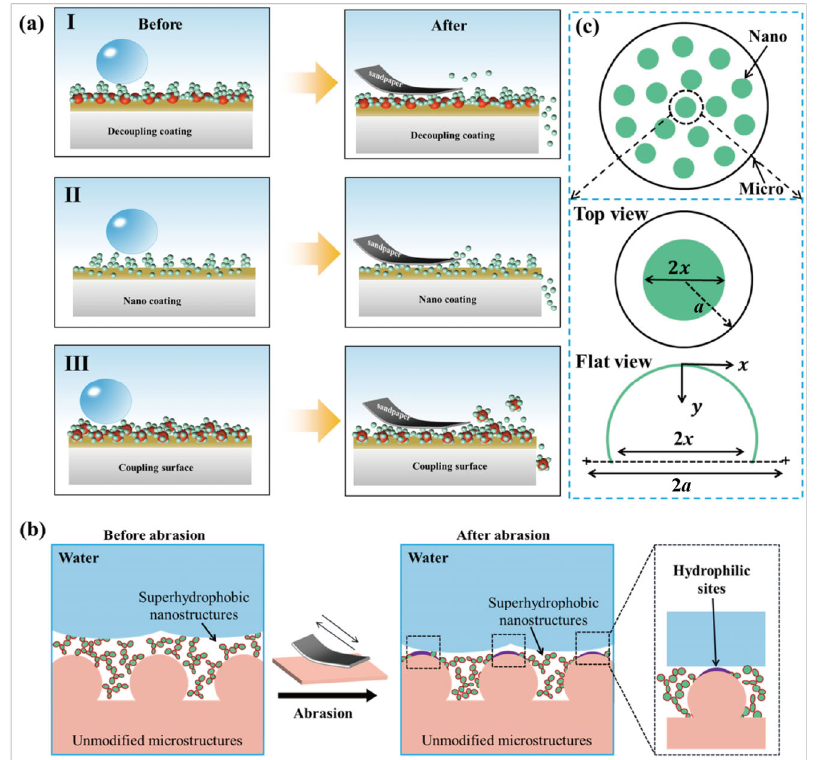
Fig. 6 (a) Schematic mechanism of three coatings before and after abrasion; (b) schematic mechanism of wear resistance on the decoupling superhydrophobic coating before and after abrasion; and (c) cross-section schematics of the decoupling superhydrophobic